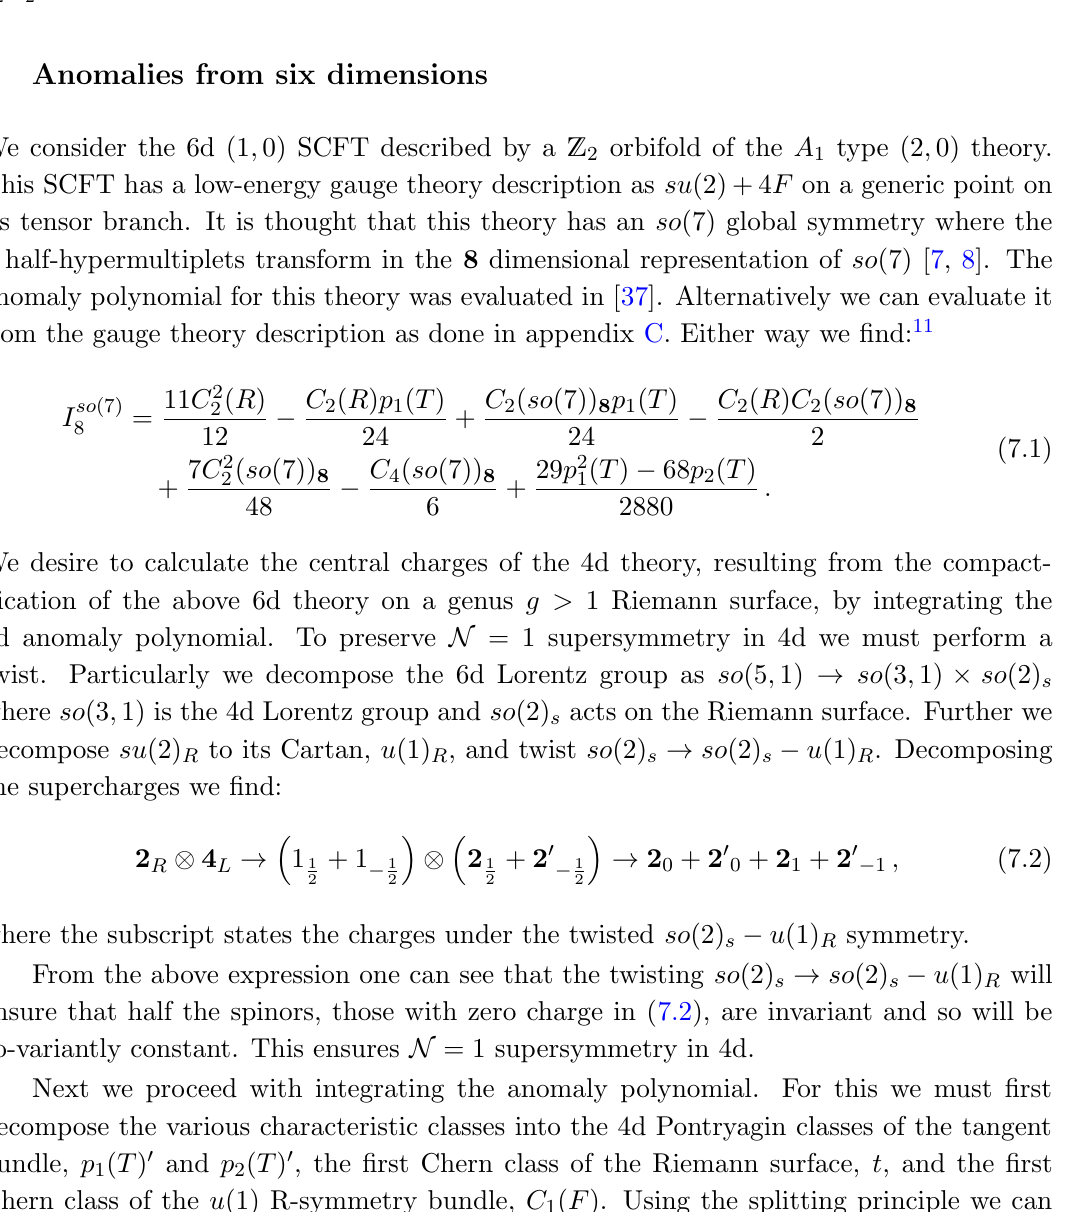
Figure 14 . Construction of genus three theory with G max = ( 1 ; 1 ; 2 2